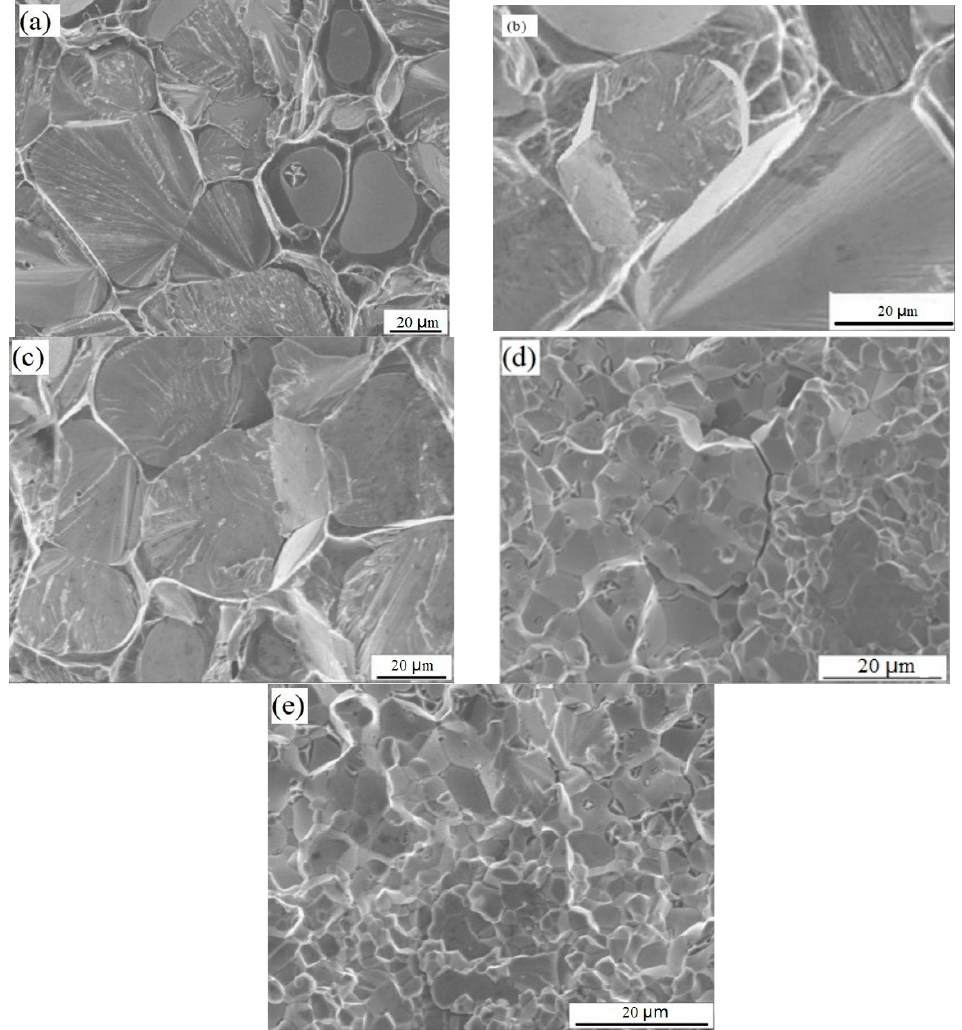
Figure 9. Fracture morphology of tungsten alloy under different HIP parameters: ( a ) sintered bar: 1200 °C, 175 MPa; ( b ) sintered bar: 1200 °C, 140 MPa; ( c ) sintered bar: 1300 °C, 140 MPa; ( d ) powders: 1300 °C, 140 MPa [19]; ( e ) powders: 1400 °C, 140 MPa [19].